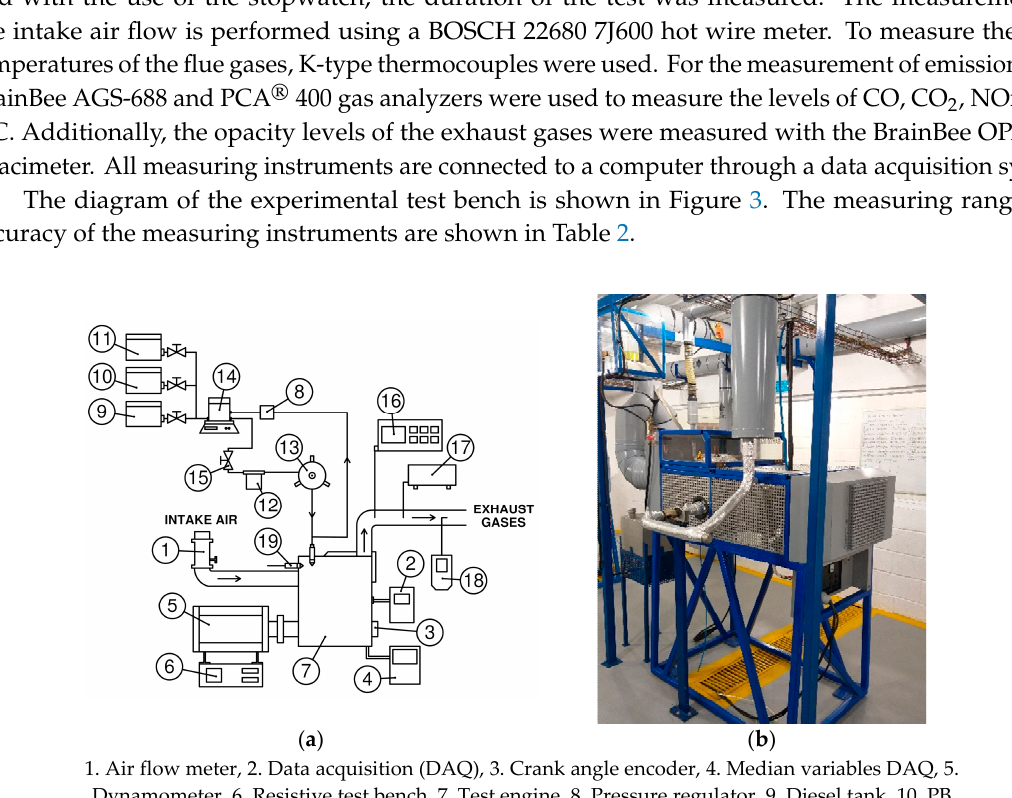
Figure 3. Engine test bench, ( a ) setup, and ( b ) devices.